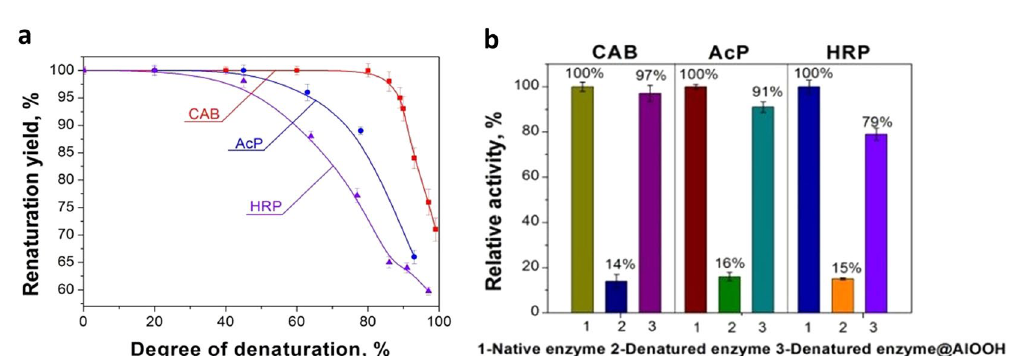
Figure 2. The effect of 8 M GdmCl denaturant on the relative activity and turbidity of a solution of CAB, AcP and HRP.